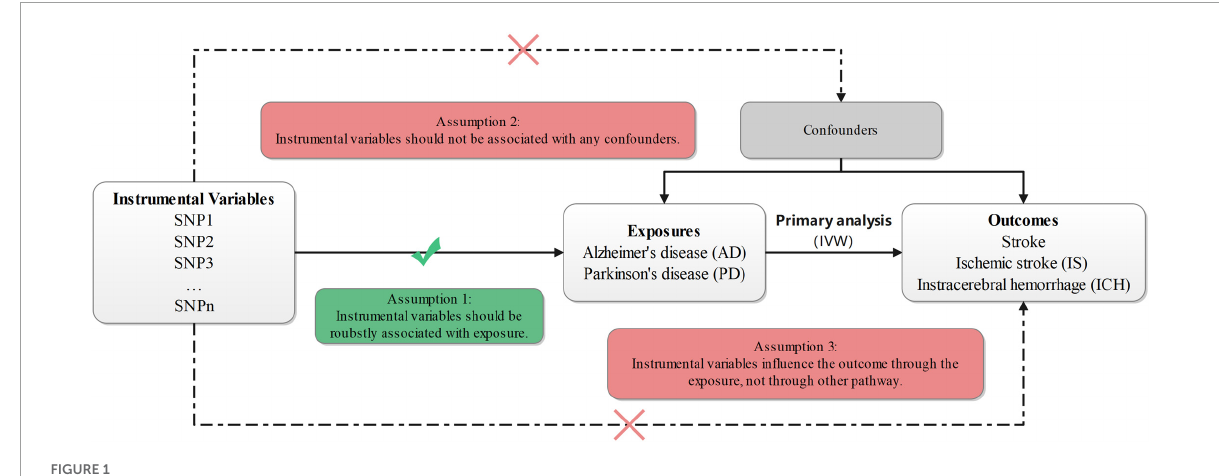
FIGURE1 Design flow chart of the present study. IVW, inverse-variance-weighted; SNP, single-nucleotide polymorphism.